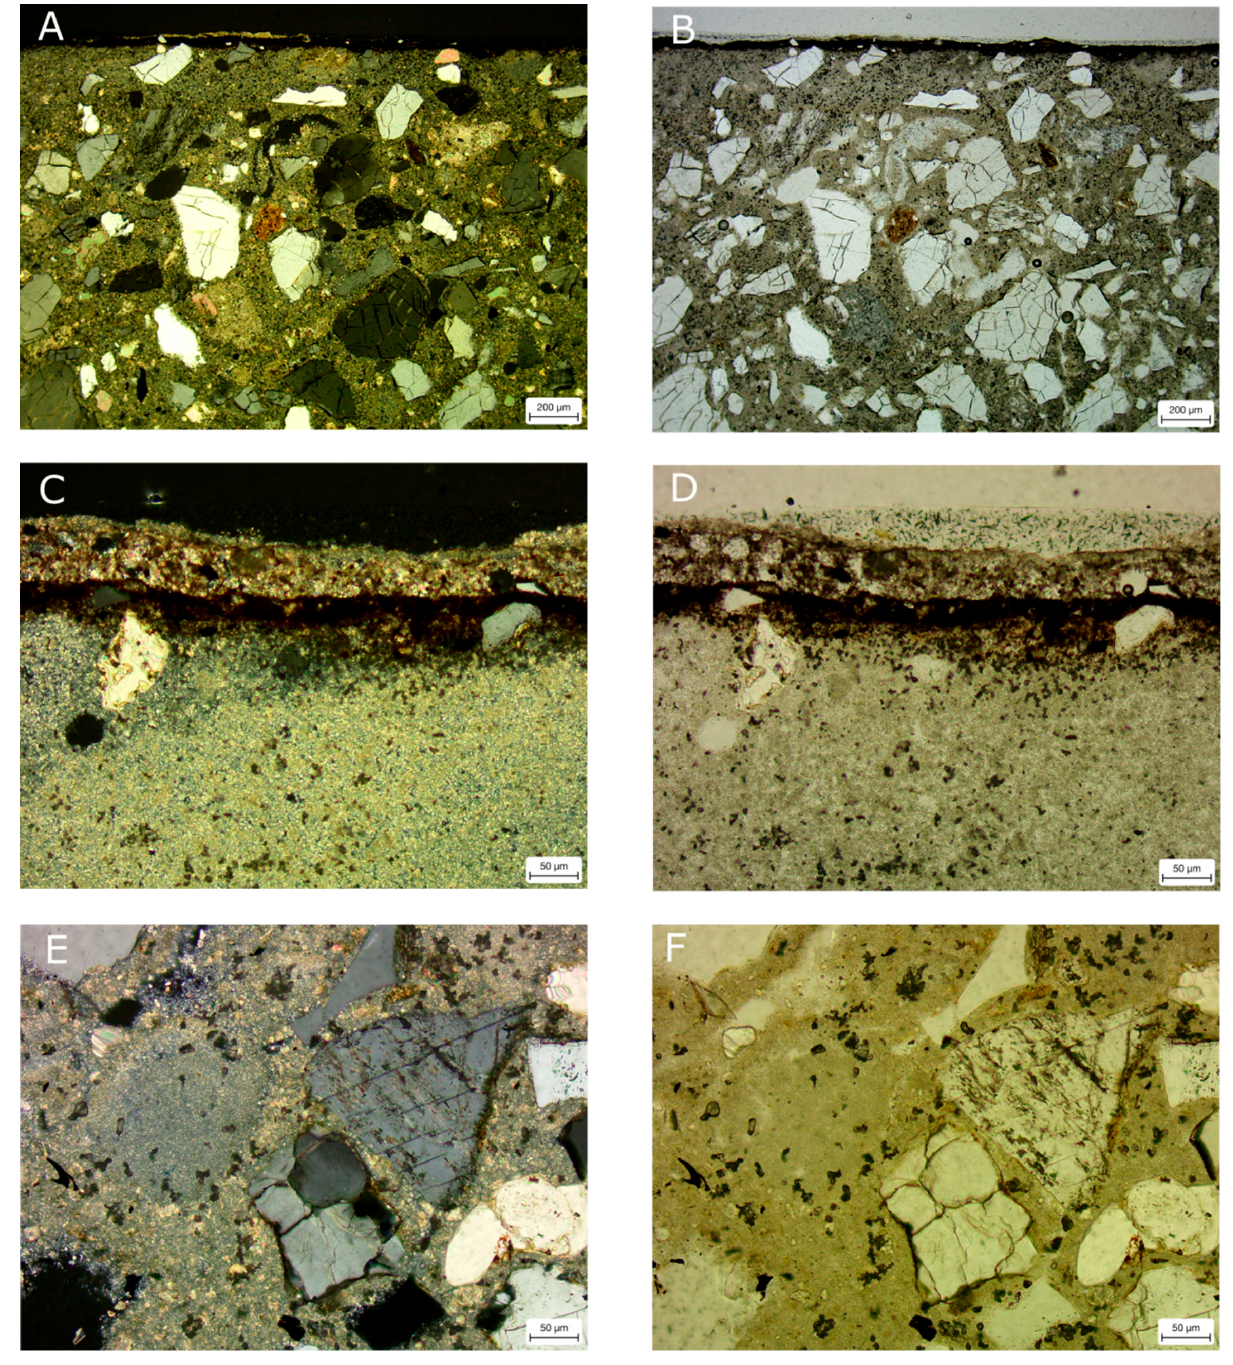
Figure 8. ( A – F ) Showing reddish aggregates ( A ); quartz grains, triangular feldspars, and plagioclase ( E , F ); and the layers checked in sample NO1 ( C , D ). The binder is carbonated, which is mostly calcite-rich and, to a lesser extent, mi- crosparite. Its appearance is generally homogeneous, with lumps appearing at some points (rounded lump in Figure 8E,F) and, very occasionally, nodules. The clay content is low. The porosity is very low (less than 5%). It could be said that this microporosity is associated with the lime